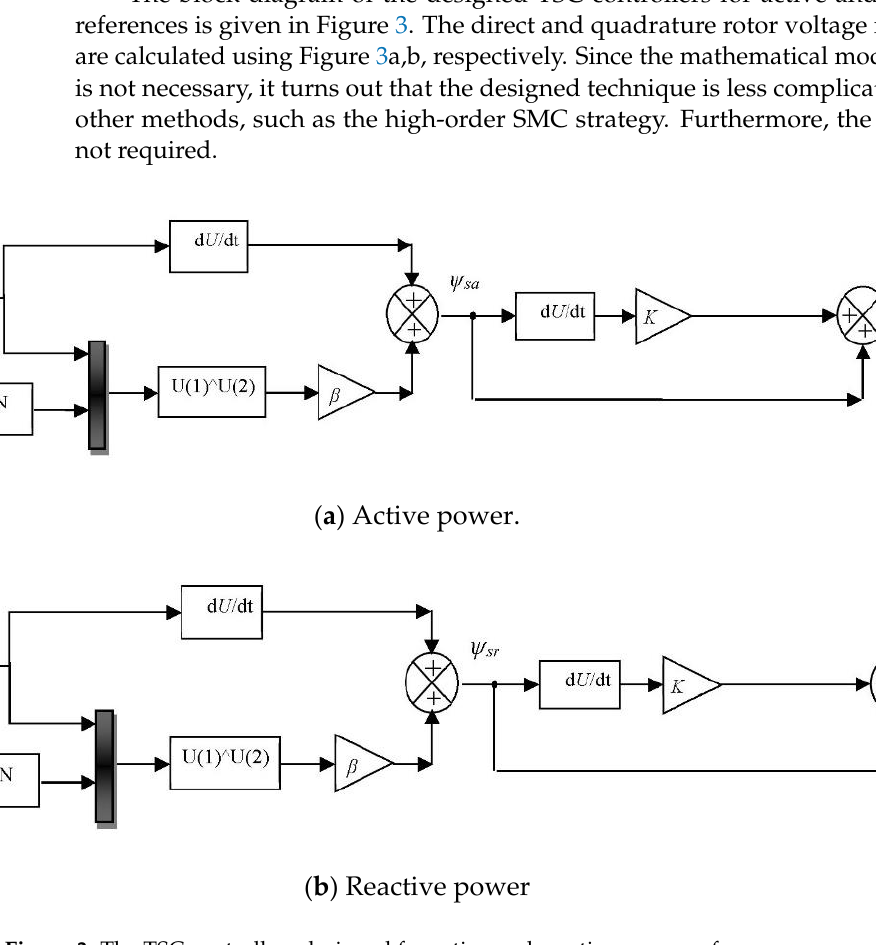
Figure 3. The TSC controllers designed for active and reactive power references.